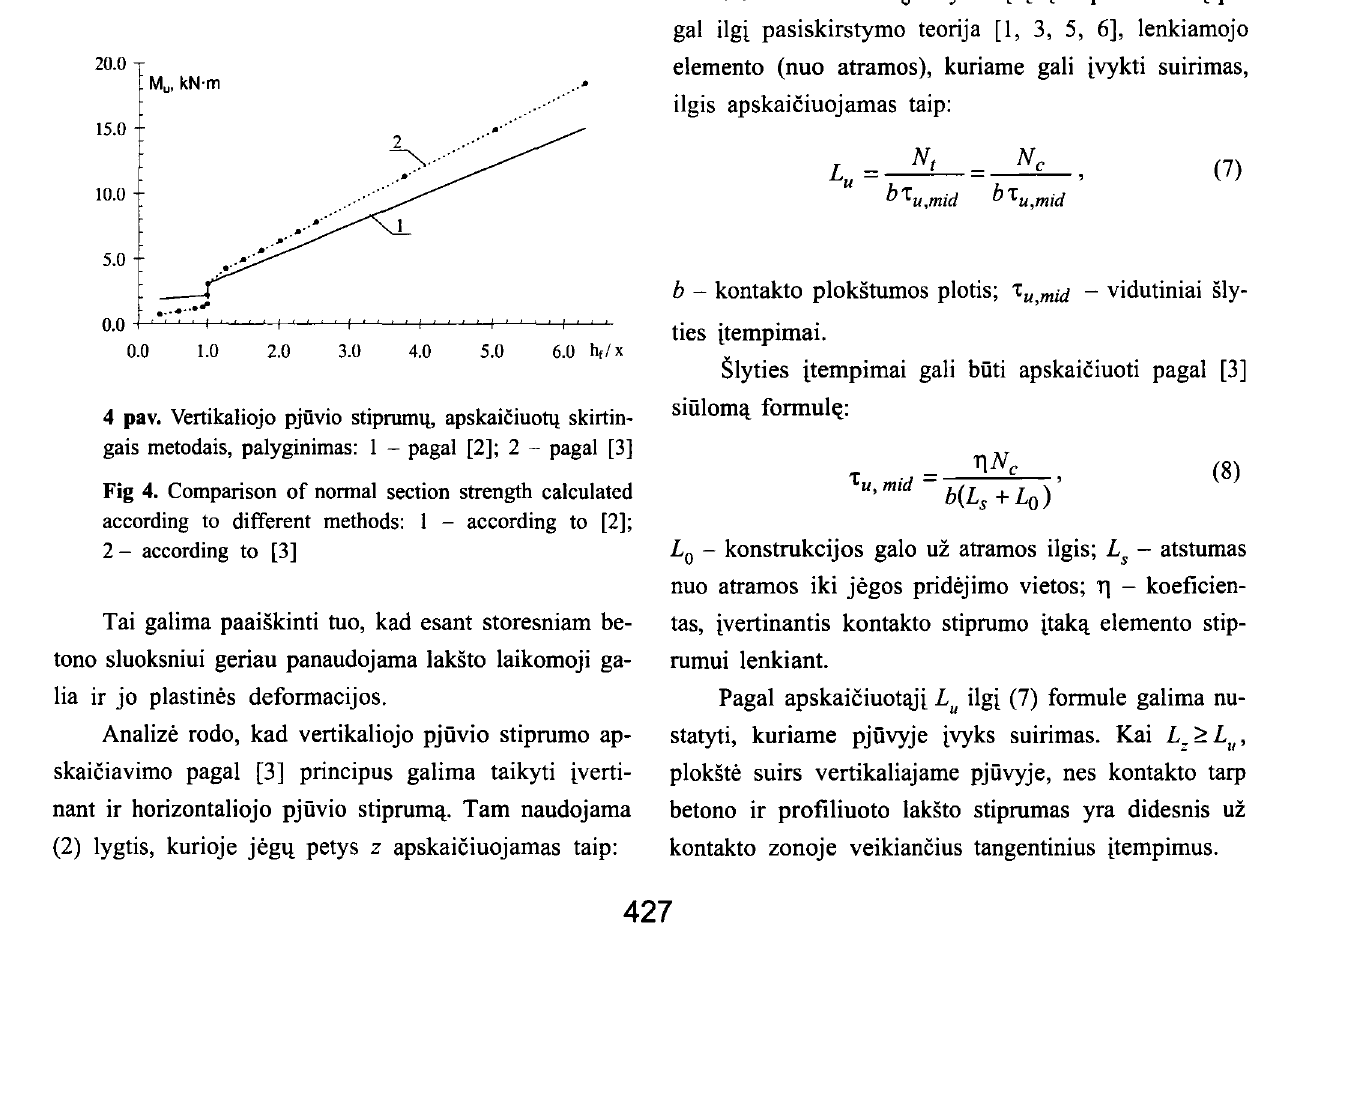
Fig 4. Comparison of normal section strength calculated